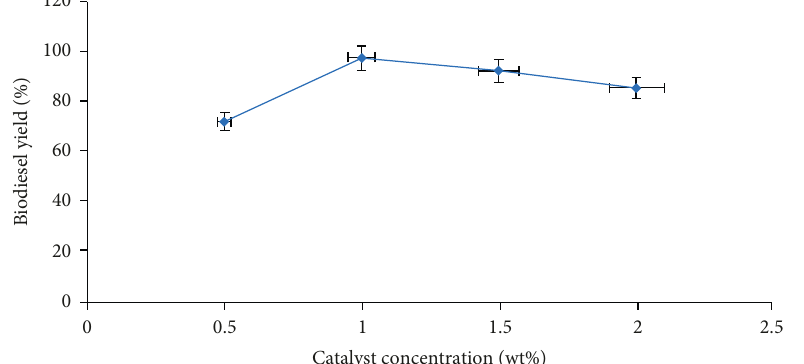
Figure 4: Effect of catalyst concentration on methyl esters yield (temperature 60 ° C; molar ratio 8:1; reaction time 1h).